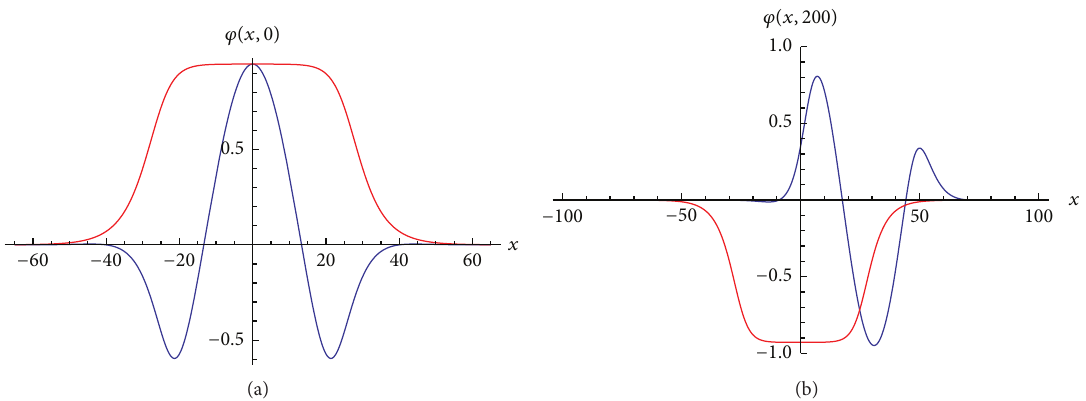
Figure 2: Profile of the flat-top oscillons in 1 + 1 -dimensions with Lorentz symmetry breaking for 𝑡 = 0 (left) and 𝑡 = 200 (right) with 𝑔 = 5 . The thin line corresponds to the case with 𝑘 00 = 0.12 , 𝑘 11 = 0.30 , 𝑘 01 = 0.27 , and 𝑘 10 = 0.21 and the thick line to the case with 𝑘 𝜇 ] = 0 .